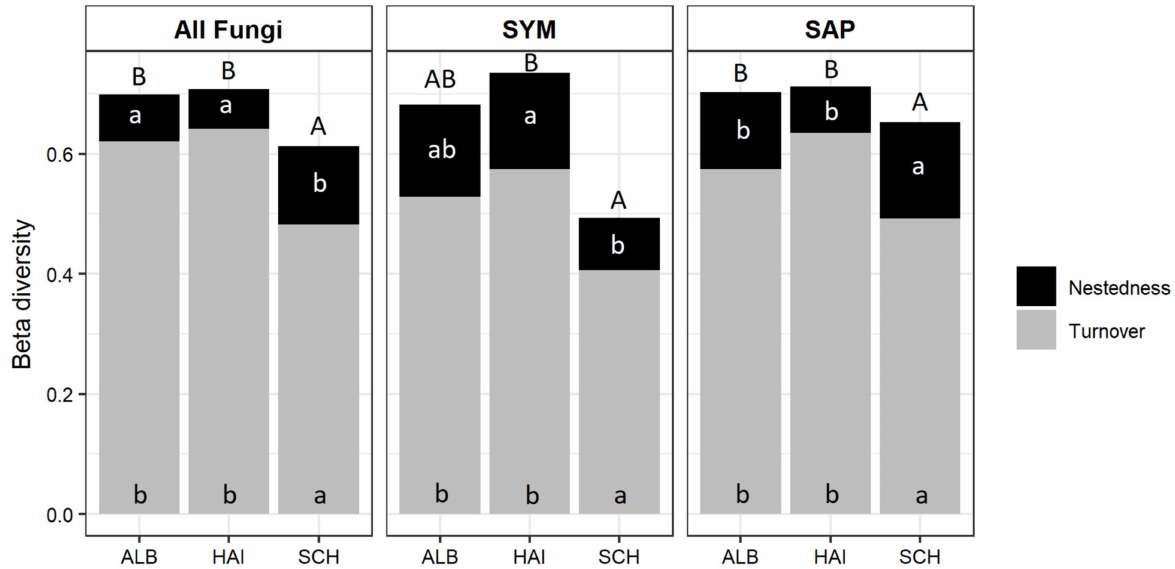
Figure 3. Beta-diversity of the root-associated fungal community composition of all (all OTUs), symbiotroph (SYM), and saprotroph (SAP) fungi between the organic layer and mineral soil. Stacked bars represent overall β -diversity ( β SOR ) for the three regions. ALB = Schwäbische Alb, HAI = Hainich-Dün and SCH = Schorfheide-Chorin. Grey sections of the bars represent the mean fungal turnover ( β SIM ), and black sections represent the mean fungal nestedness ( β SNE ). Pairwise differences of each variable were compared separately among the regions using a post hoc test (HSD Tukey’s honestly significant difference). Different letters represent significant differences of the means at p ≤ 0.05. Capital letters refer to significant differences for the overall beta diversity and small letters for the turnover and nestedness components of the beta